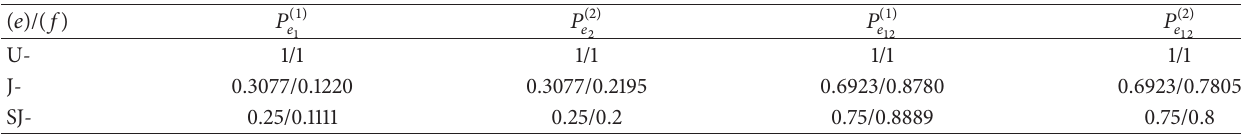
Table 2: The 𝑃 (𝑗) 𝑒 obtained by “U”, “J-”, and “SJ-”: two-target situation. 𝑟